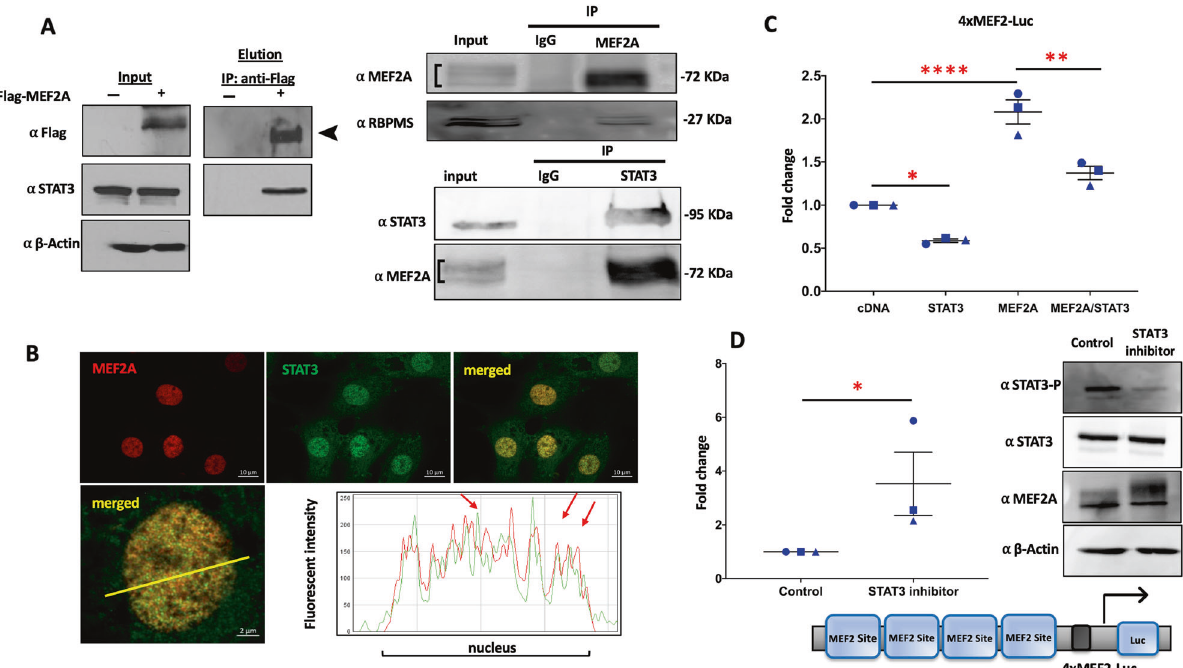
Fig. 3 Validation of selected putative interactions. A PCMs were transfected with a Flag-MEF2A construct and lysates were assessed for expression by Western blotting. Flag-MEF2A lysates were used for IP using α -Flag magnetic beads and the eluates were blotted with anti-Flag and STAT3 antibodies. IP with lysates from non-transfected PCMs were used as negative controls (Left panel). Non-transfected PCM lysates were used for IP using MEF2A antibody to con fi rm the interaction between endogenous MEF2A and RBPMS. IP with IgG was used as controls (Top right). Non-transfected PCM lysates were used for IP using a STAT3 antibody IP to con fi rm the interaction between endogenous STAT3 and MEF2A. IP with IgG was used as control (Bottom right). Number of biological replicates carried out for the Western blot and IP data is n = 3. B Confocal immuno fl uorescence analysis of endogenous MEF2A and STAT3 indicates a nuclear localization in PCMs. PCMs were fi xed and stained for MEF2A in red and counterstained for STAT3 in green. Slides were analyzed by confocal microscopy. The scale bars are 2